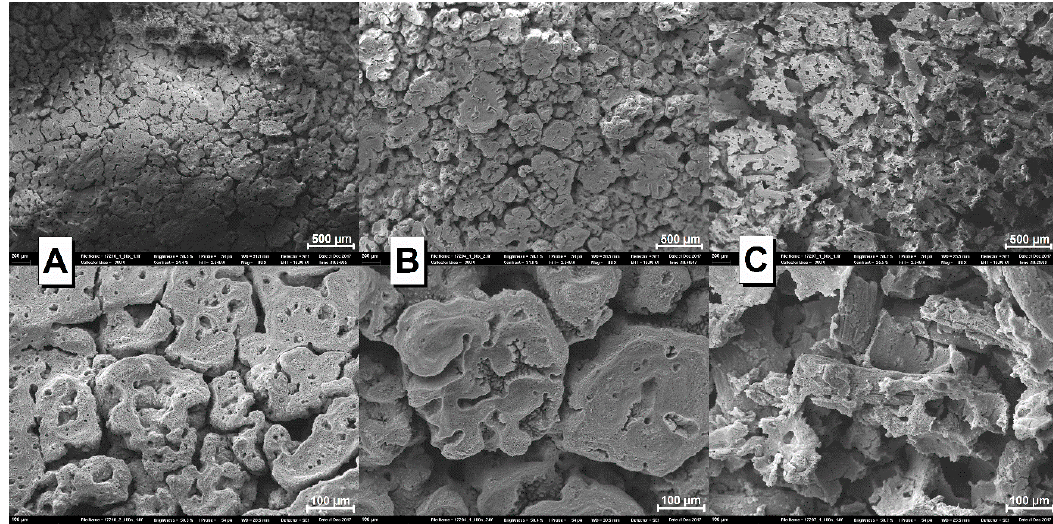
Figure 16. SEM micrographs of the cone calorimeter residue surfaces of TPS/10APP ( A ), TPS/20KF/10APP ( B ) and TPS/20CF/10APP ( C ) at two different magnifications (top and bottom).